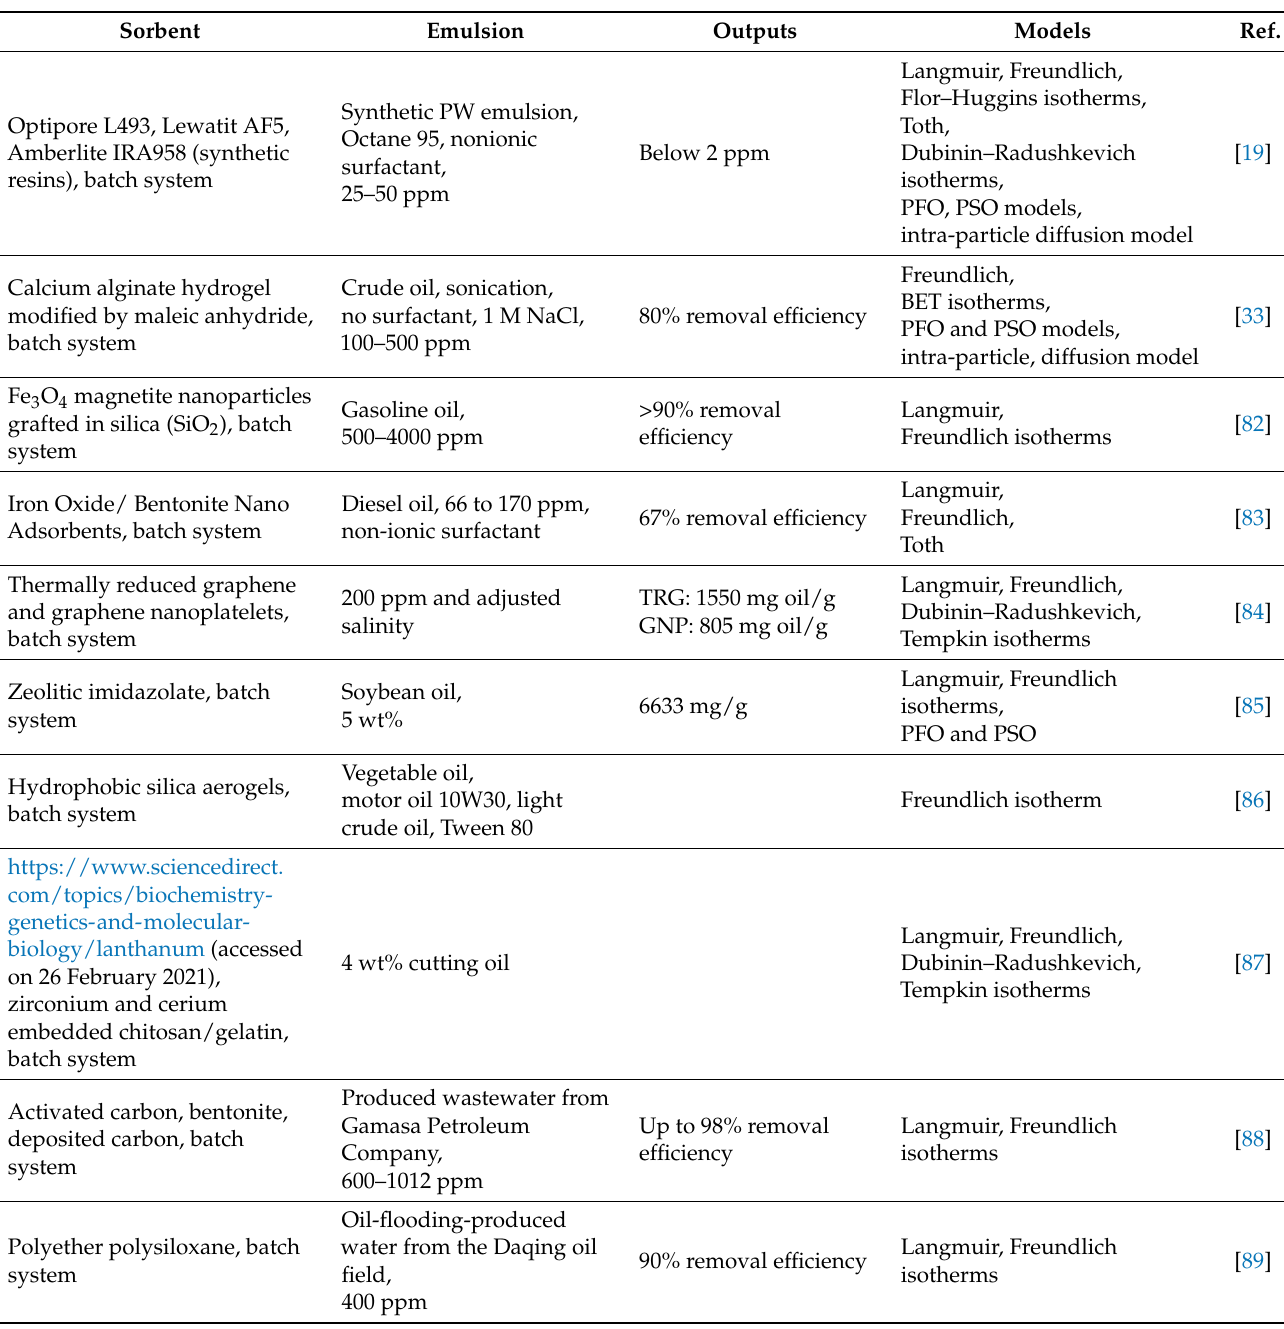
Table 2. The models used for sorption of oil by the use of various